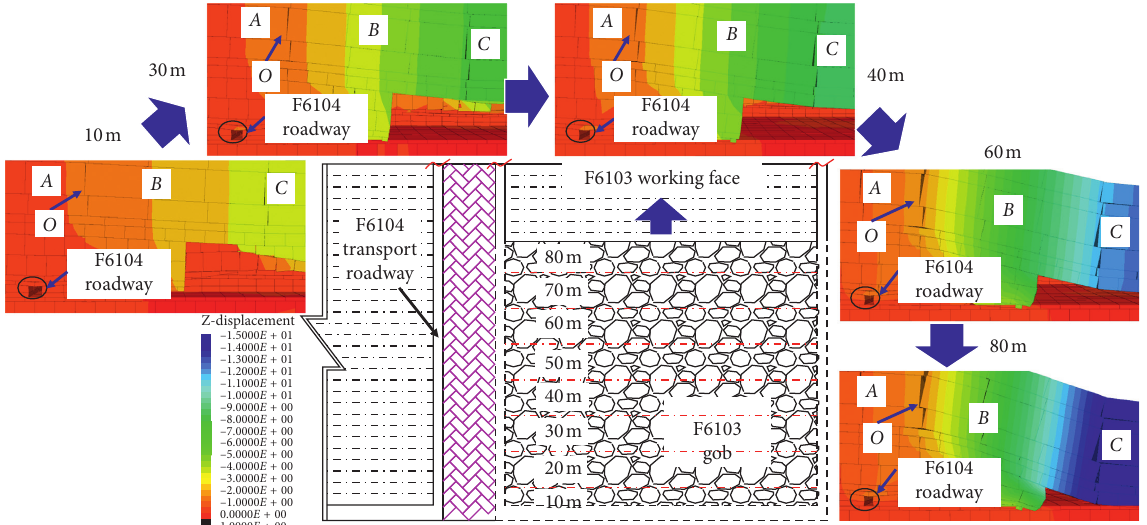
Figure 6: Fracture characteristics and vertical displacement of the roadway under the influence of